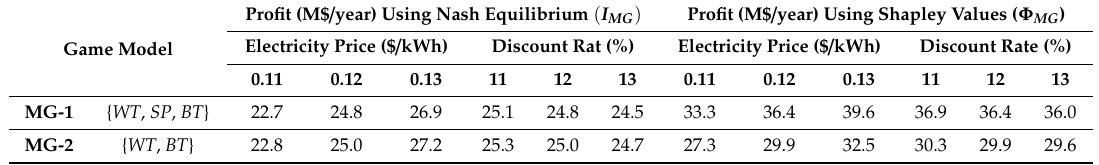
Figure 5. Sensitivity analysis for game theory techniques: ( a ) Nash equilibrium; ( b ) Shapley values. Table 4. Sensitivity analysis of networked microgrid for game theory